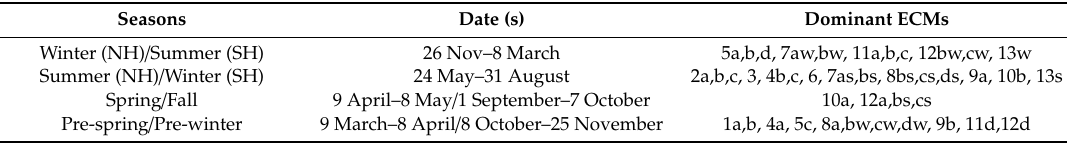
Table 2. Seasonal circulation